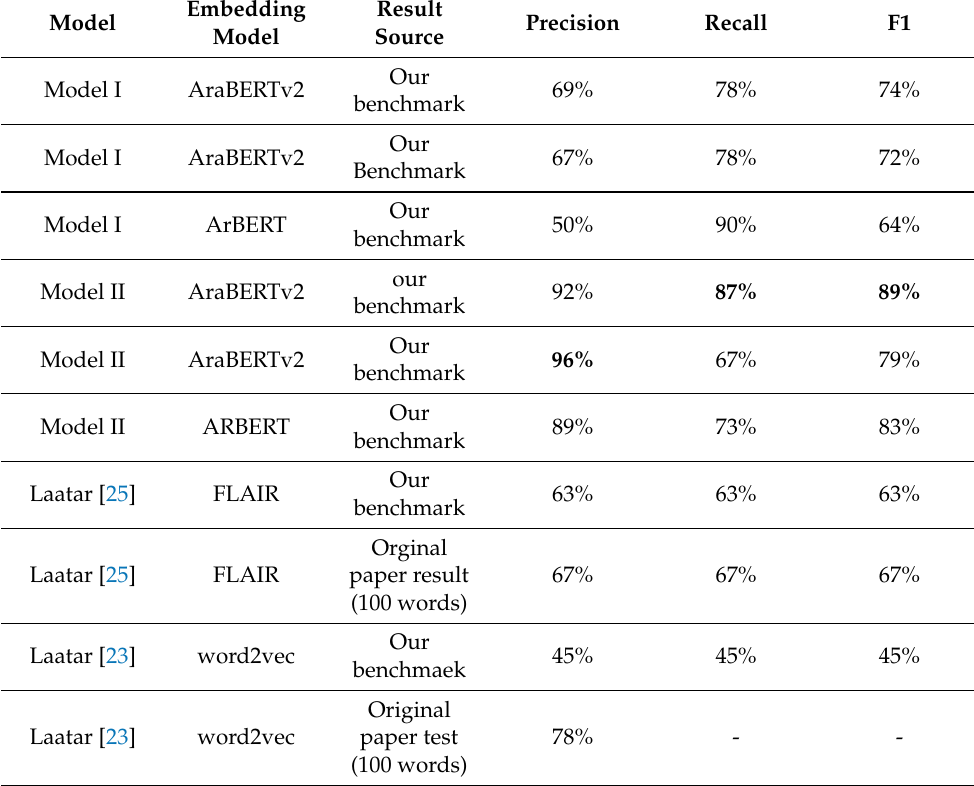
Table 9. Embedding-based models vs. our models.